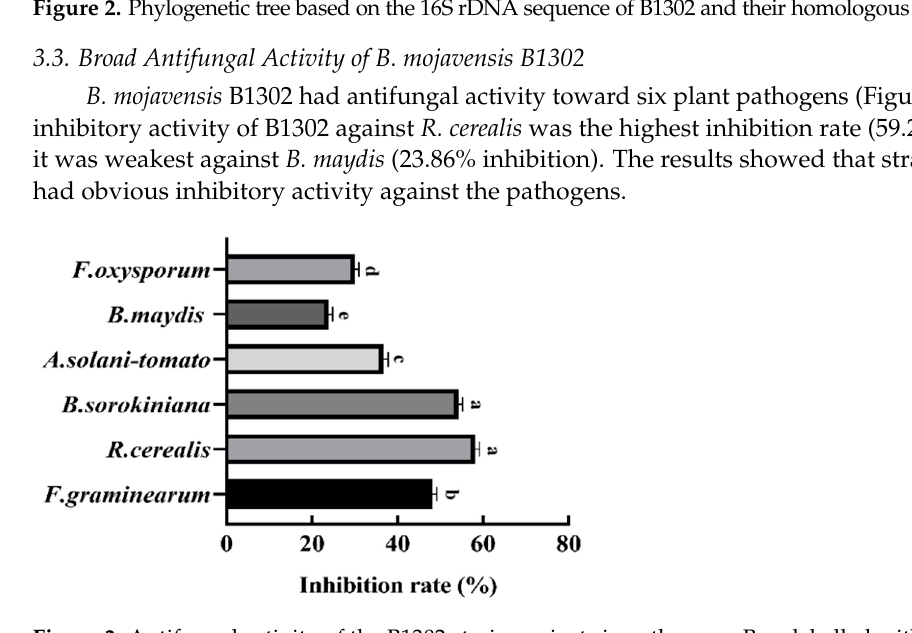
Figure 4. Effect of cultivation medium components and cultural conditions on the activities of strain B1302 against R. cerealis . ( A ), Carbon (c1, corn; c2, glycerin; c3, wheat bran; c4, sucrose; c5, glucose);